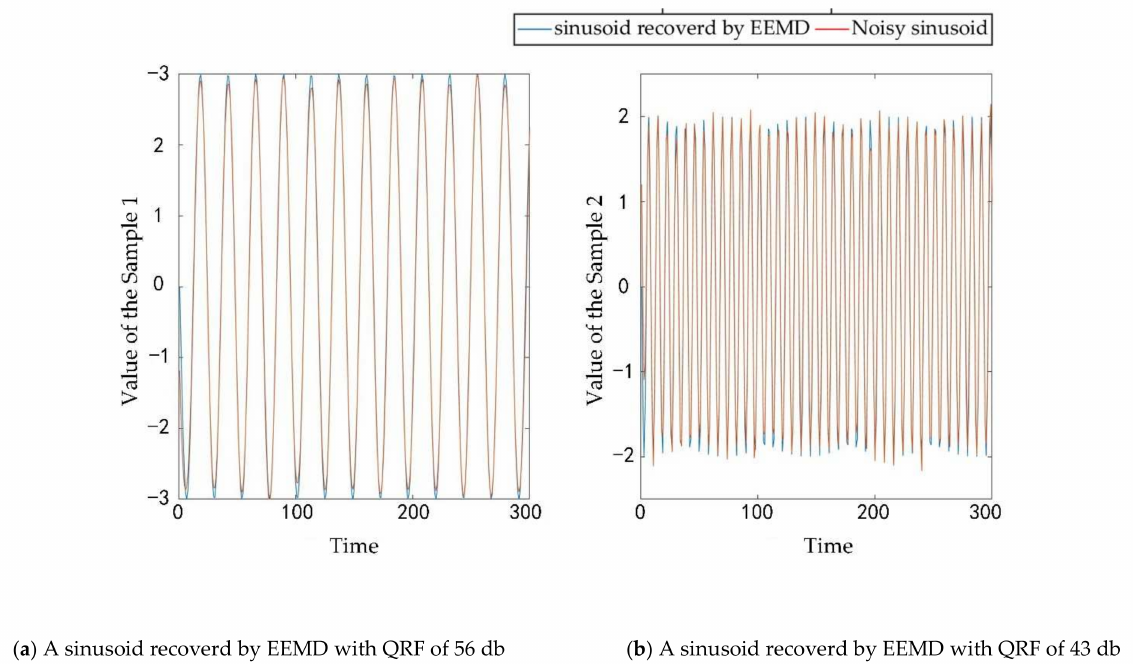
Figure 3. Samples decomposed by